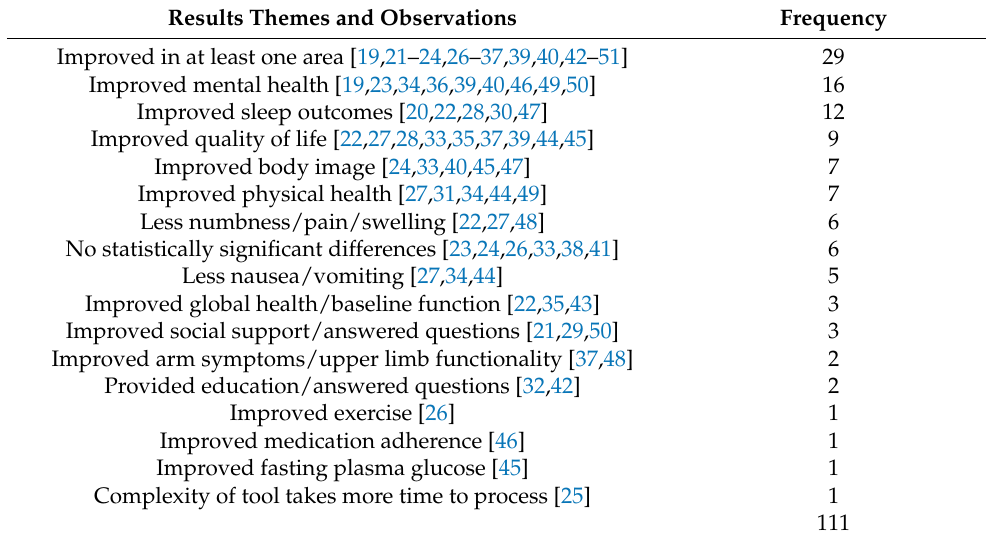
Table 3. Results of studies, compared to control group.